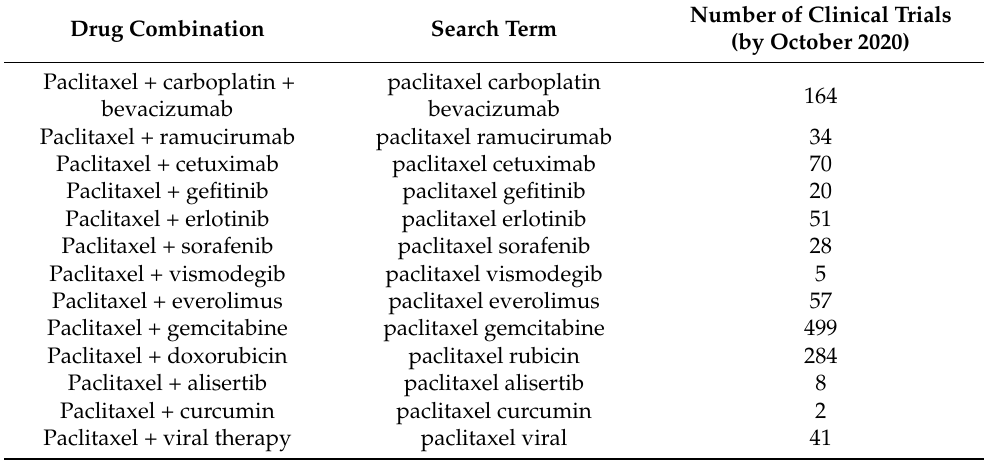
Table 4. Selected clinical trials for cancer treatment with paclitaxel in combination with other anticancer